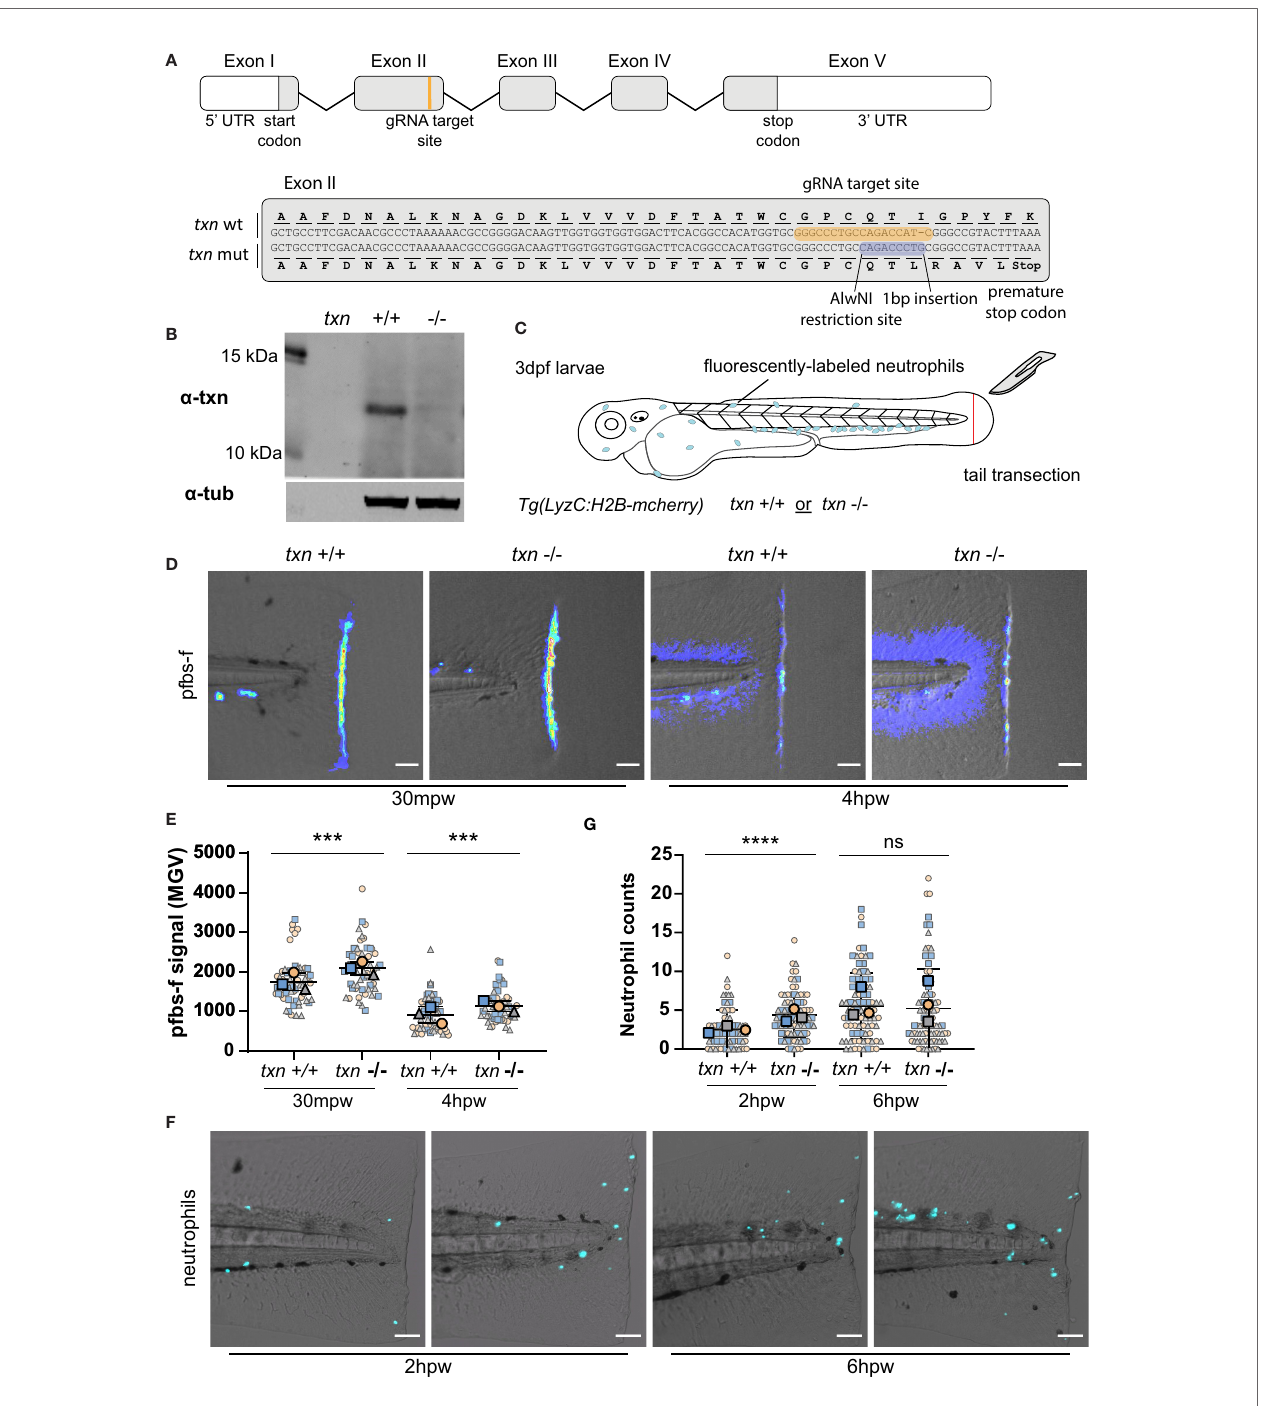
FIGURE 3 | Thioredoxin regulates neutrophil recruitment and redox balance in damaged tissues. (A) Schematic of txn gene with annotations of gRNA target site and 1bp insertion identi fi ed in txn mutant larvae. (B) Western blot of Txn and a Tubulin on whole lysates from txn wildtype and mutant larvae. (C) Schematic of tail transection assay to measure neutrophil recruitment and H 2 O 2 abundance conducted on txn +/+ Tg( LyzC : H2B-mcherry ) or txn -/- Tg( LyzC : H2B-mcherry ) larvae 3dpf. (D) pfbs-f probe for H 2 O 2 (1uM) in response to tail transection 30mpw (wt n=56, mut n=54) and 4hpw (wt n=51, mut n=51) with (E) quanti fi cation of signal density in region posterior to notochord. (F) Neutrophil recruitment in response to tail transection 2hpw (wt n=79, mut n=85) and 6hpw (wt n=87, mut n=90) with (G) quanti fi cation of neutrophil abundance in region posterior to notochord. Scale bar, 50um. Large, bolded shapes indicate average value per replicate (n), with small shapes representing data points from independent larvae. Samples were analyzed for statistical signi fi cance by Mann-Whitney U test (p < 0.001***, p < 0.0001****). ns, not signi fi